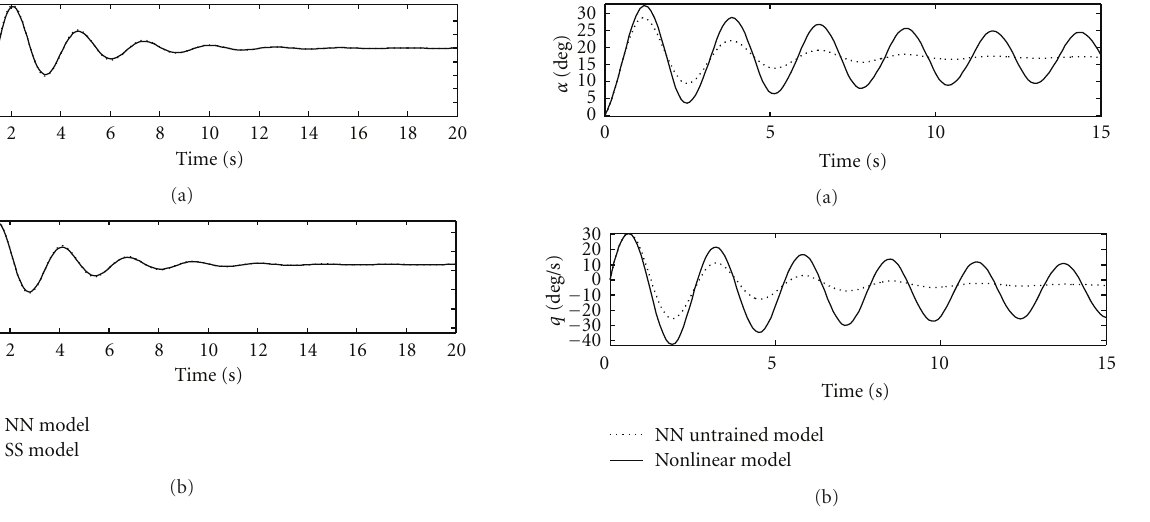
Figure 5: Linear NN model versus state-space model for fighter linearized dynamics.